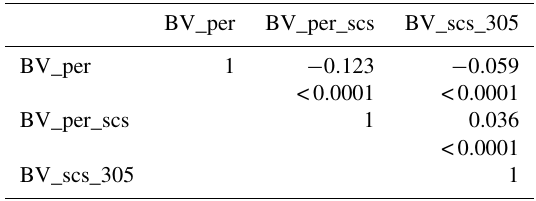
Table 4. Correlations between BV of lactation persistency and BVs of somatic cell score.